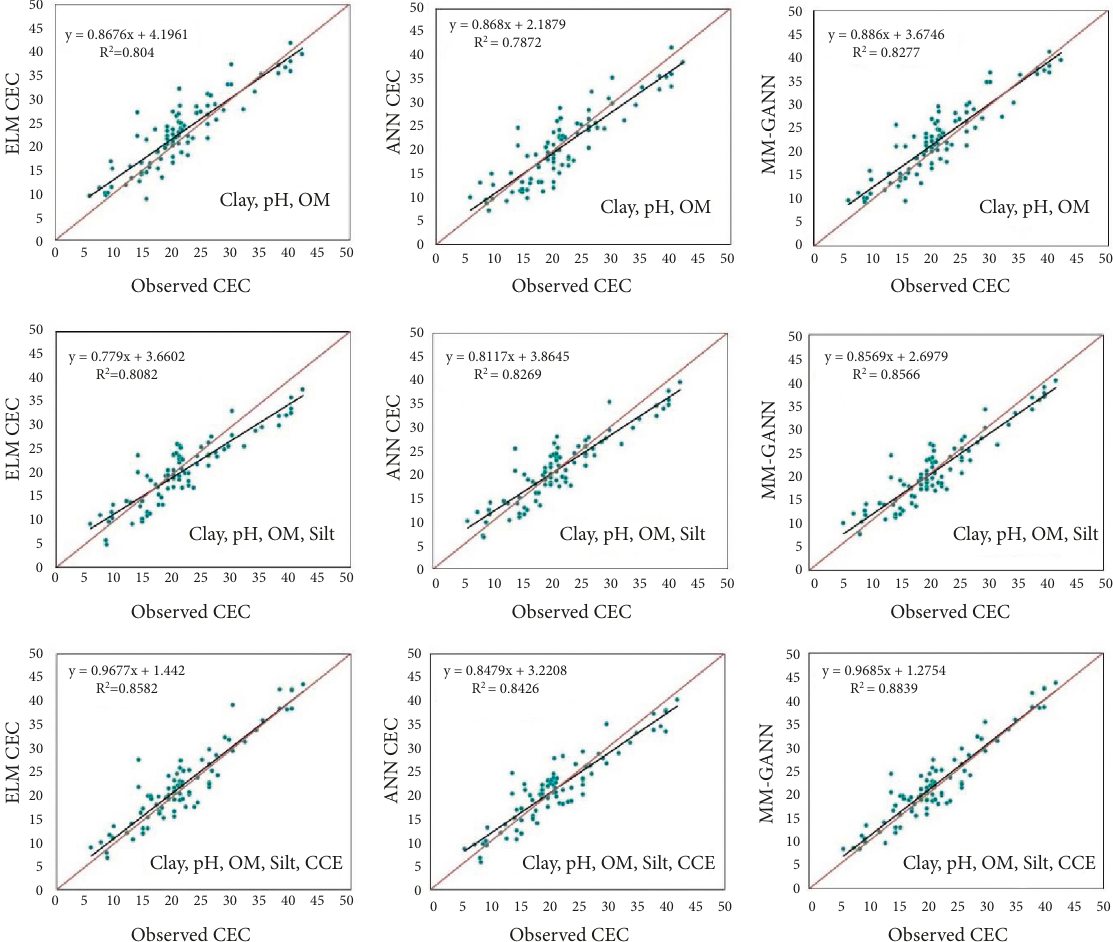
Figure 9: The observed and estimated soil CEC in the test stage: ELM, ANN, and MM-GANN models.